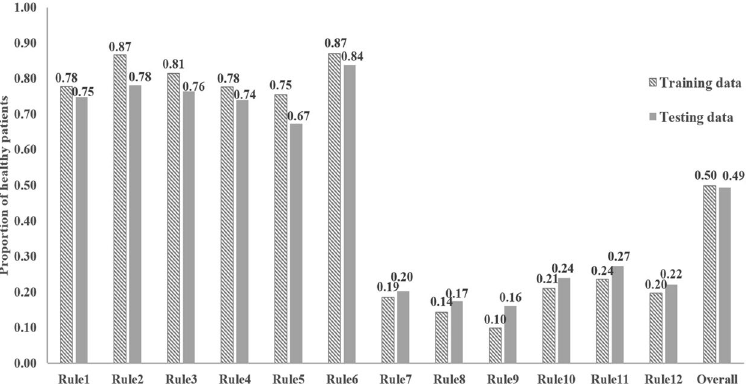
Figure 2. Proportion of low-risk patients (average PHQ-9 score < 10) in rule-endorsing